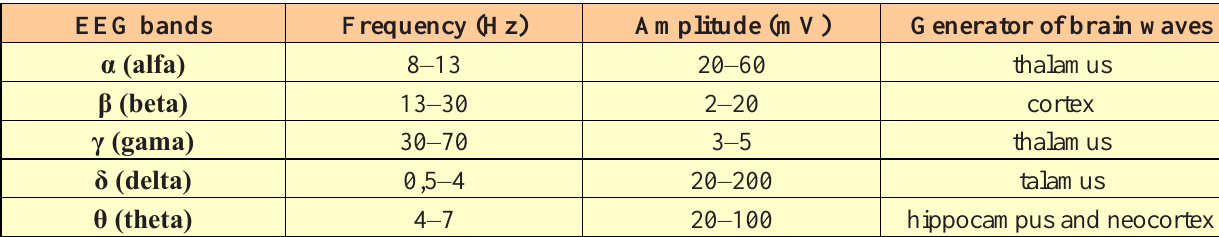
Table 1. Basic characteristics of EEG wave